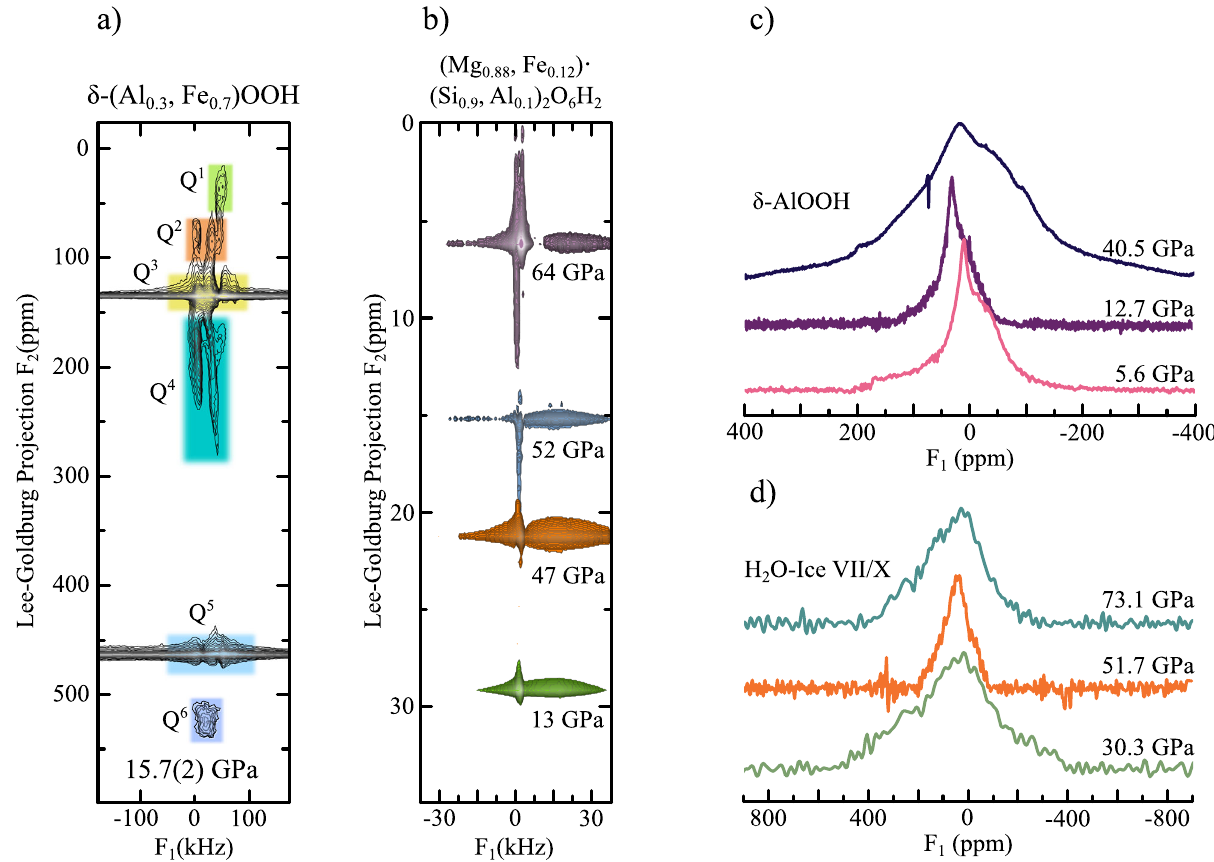
Fig. 3 1 H-NMR spectra of all sample systems. a High-resolution 2D-Lee Goldburg (LG) spectrum of δ -(Al 0.3 ,Fe 0.7 )OOH at 15.7 GPa showing up to six distinguishable hydrogen signals in the indirect LG projection F 2 20 . Assuming a stochastic distribution of ferric iron in the sample, a comparison with signal intensities allows for the assignment of the H-bond species Q i (i = 1 – 6). Spectra at different pressures were recorded at reduced resolution due to experimental time restrictions and solely signals from Q 3 , Q 5 and Q 6 species were recorded over the full pressure range. The integration limits for 2D signal intensity determination were de fi ned by 35 kHz in the direct time domain F 1 and by the FWHM of each signal in the indirect LG-projection dimension F 2 . The colored regions are guide to the eyes and do not correspond to the integration limits. b High-resolution 2D-LG spectra of dense magnesium silicate phase-D, showing a shift towards lower chemical shifts at the HS → LS crossover (Fig. 4a). Measurements were conducted at a magnetic fi eld of 7.04 T. fi eld of 1.2 T. Figures a and 1 H-NMR solid-echos of c δ -AlOOH and d H 2 O ice-VII/X as a function of pressure. Measurements were conducted at a magnetic b are reproduced from ref. 20 ; licensed under a Creative Commons Attribution (CC BY) license. NATURE COMMUNICATIONS| (2022) 13:3042